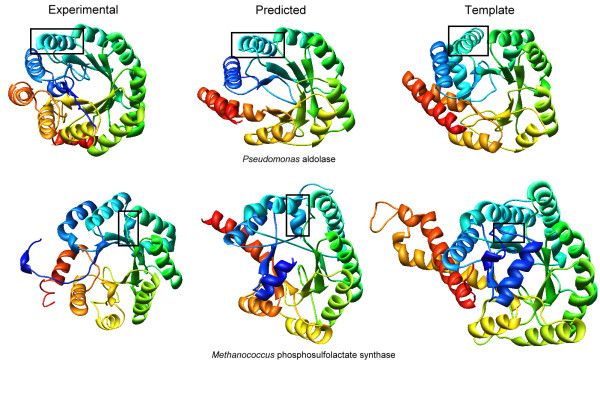
Examples where global protein similarity is not adequate to predict function. Shown are the experimental, predicted, and template structures for protein targets Pseudomonas aldolase (PDB identifier 1nvm-A) and Methanococcus phosphosulfolactate synthase (PDB identifier 1qwg-A) colored by the direction of the chain (blue to red). In both cases, the template and predicted structures have the correctly assigned fold but incorrectly assigned function based on similarity. The predicted structures resemble the template structures overall, but some local features (orientation of the second helix in upper panel and an extra helix-like region in lower panel, shown as black boxes in figure) are more similar to what is observed in the experimental structures. Since the FSSA algorithm uses both local sequence and structure information to determine function, it is less susceptible to such biases in global structure when classifying protein function.